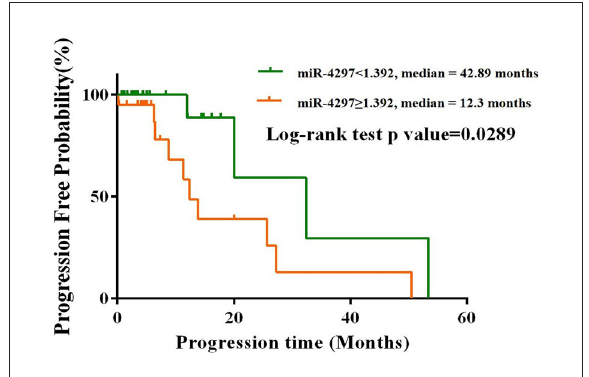
FIGURE4 Kaplan–Meier progression-free survival curves for glioma female patients stratified by serum miR-4297